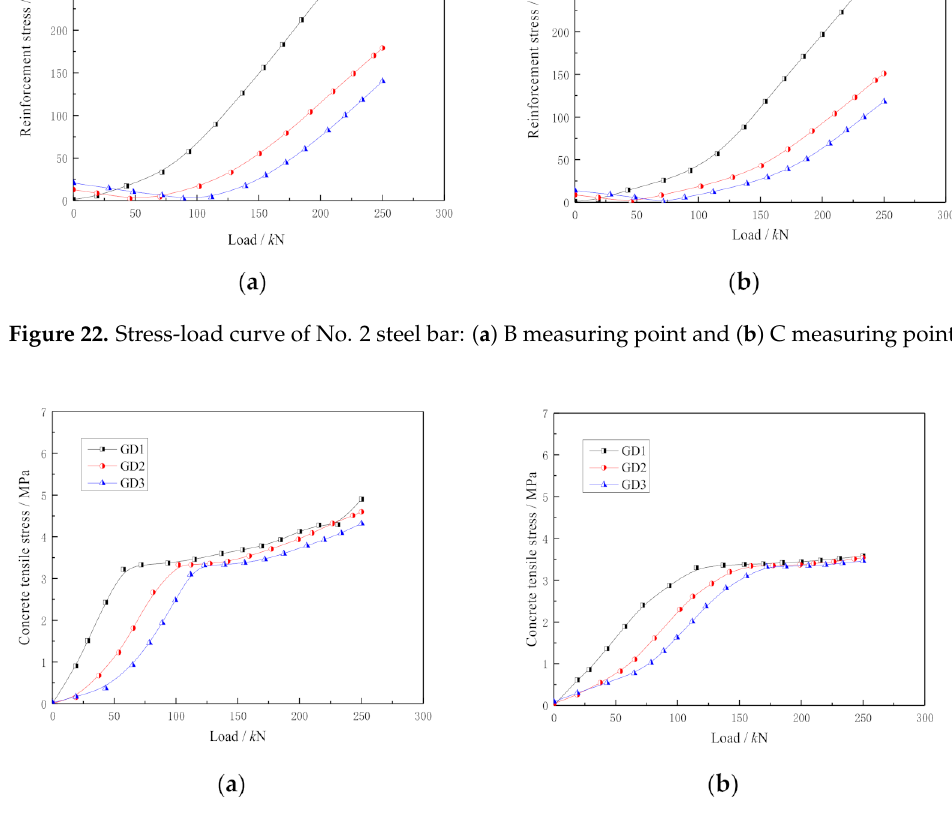
Figure 23. Strain-load curve of No. 1 concrete: ( a ) B measuring point and ( b ) C measuring